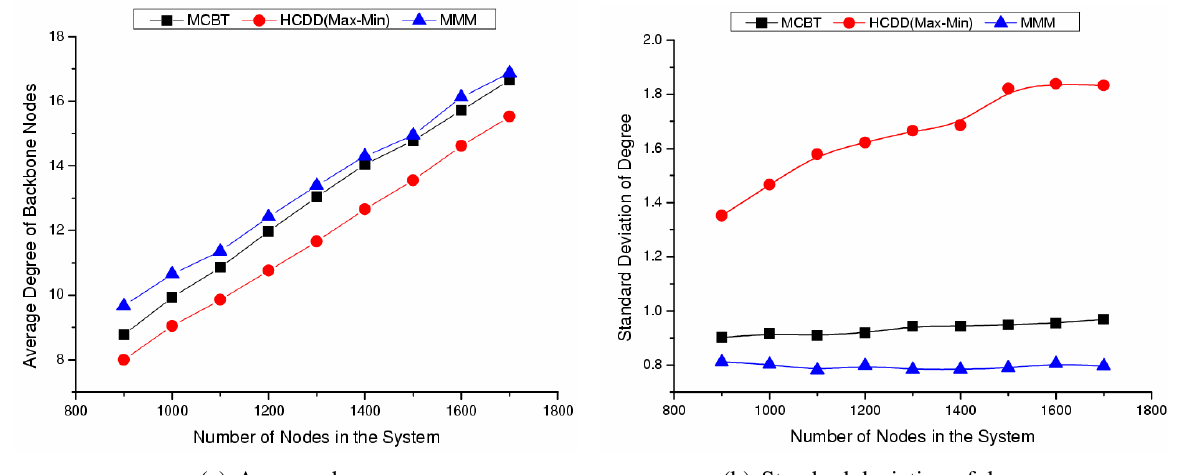
Figure 7. Degree of backbone